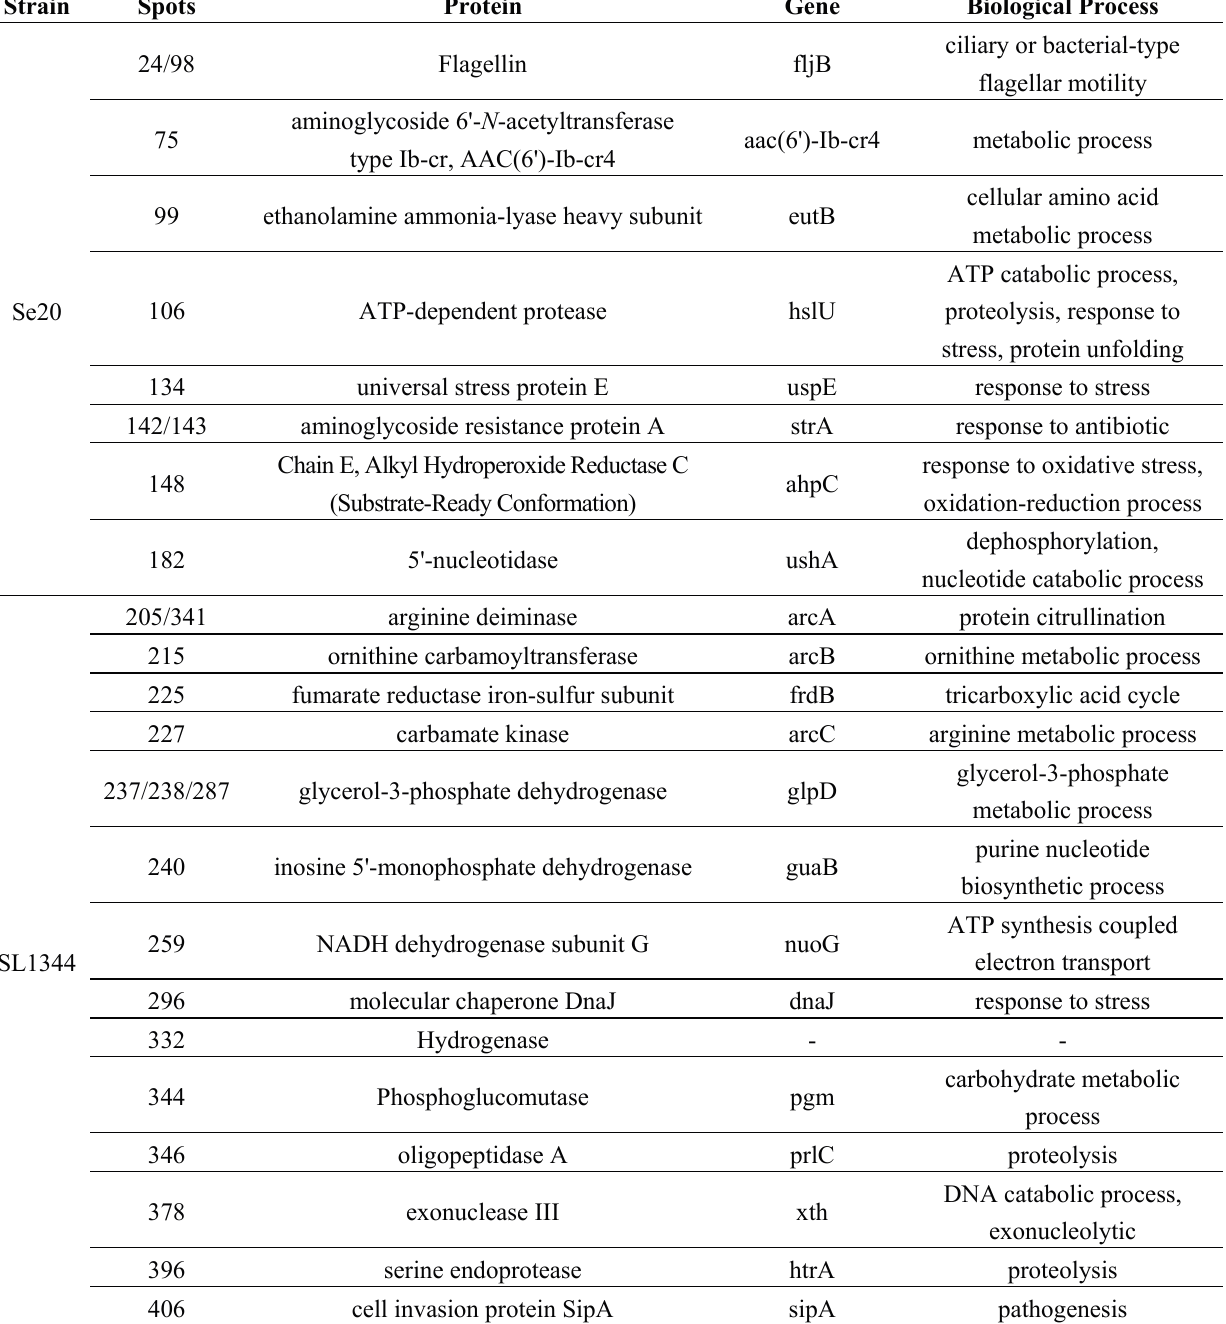
Table 2. List of some relevant proteins exclusively identified either in Salmonella Typhimurium strain Se20 or in Salmonella Typhimurium strain